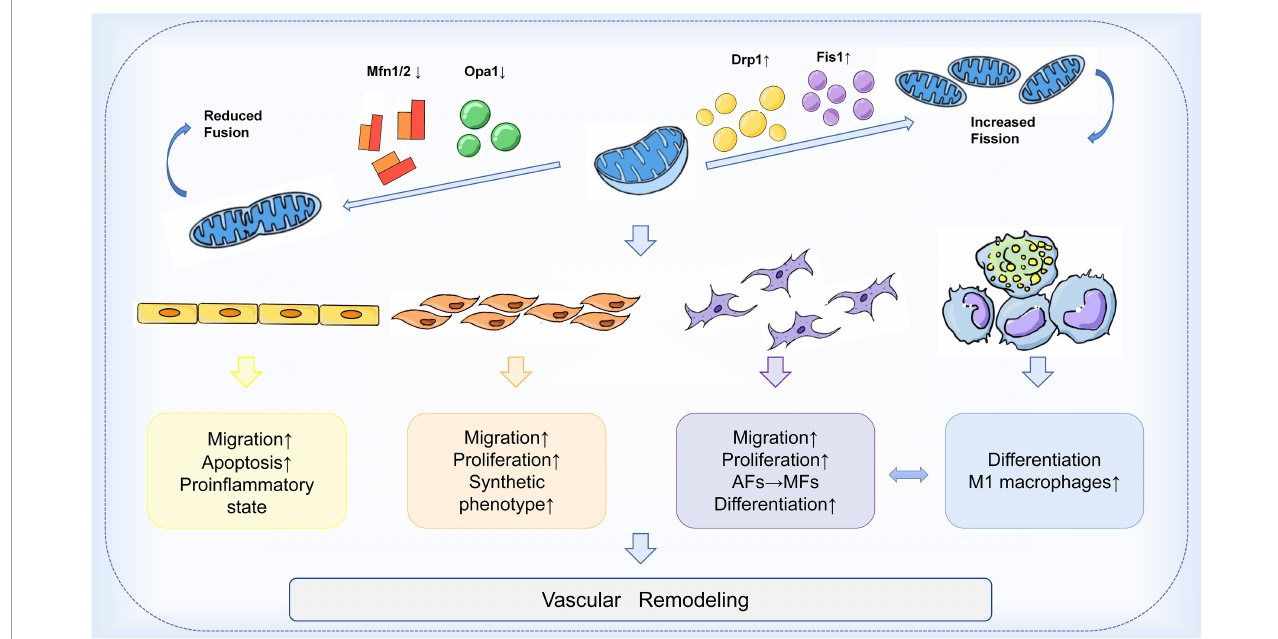
FIGURE2 Mechanism of mitochondrial dynamics in vascular remodeling. During vascular remodeling, multiple cells of the vessel wall are regulated by mitochondrial dynamics. Mitochondrial division and fusion play an important role in regulating the migration, apoptosis, and pro-inflammatory state of endothelial cells, and are also involved in the transformation of the synthetic phenotype of VSMCs and the process of phenotypic changes from adventitial fibroblasts (AFs) to myofibroblasts (MFs). Mitochondrial kinetic imbalance is also an important factor in the proliferation and migration of VSMCs and AFs. In addition to these, the delicate balance between mitochondrial fission and fusion seems to be involved in regulating macrophages and the interactions between VSMCs and macrophages, thus affecting vascular